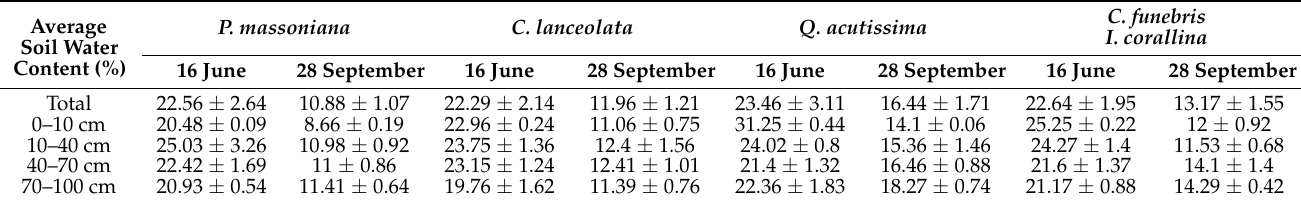
Figure 3. Vertical profiles (0–100 cm) of gravimetric water content of soil for Plot 1 ( a ), Plot 2 ( b ), Plot 3 ( c ), Plot 4 ( d ). Error bars represent the standard deviation ( N = 3). Table 3. Average soil water content of different soil